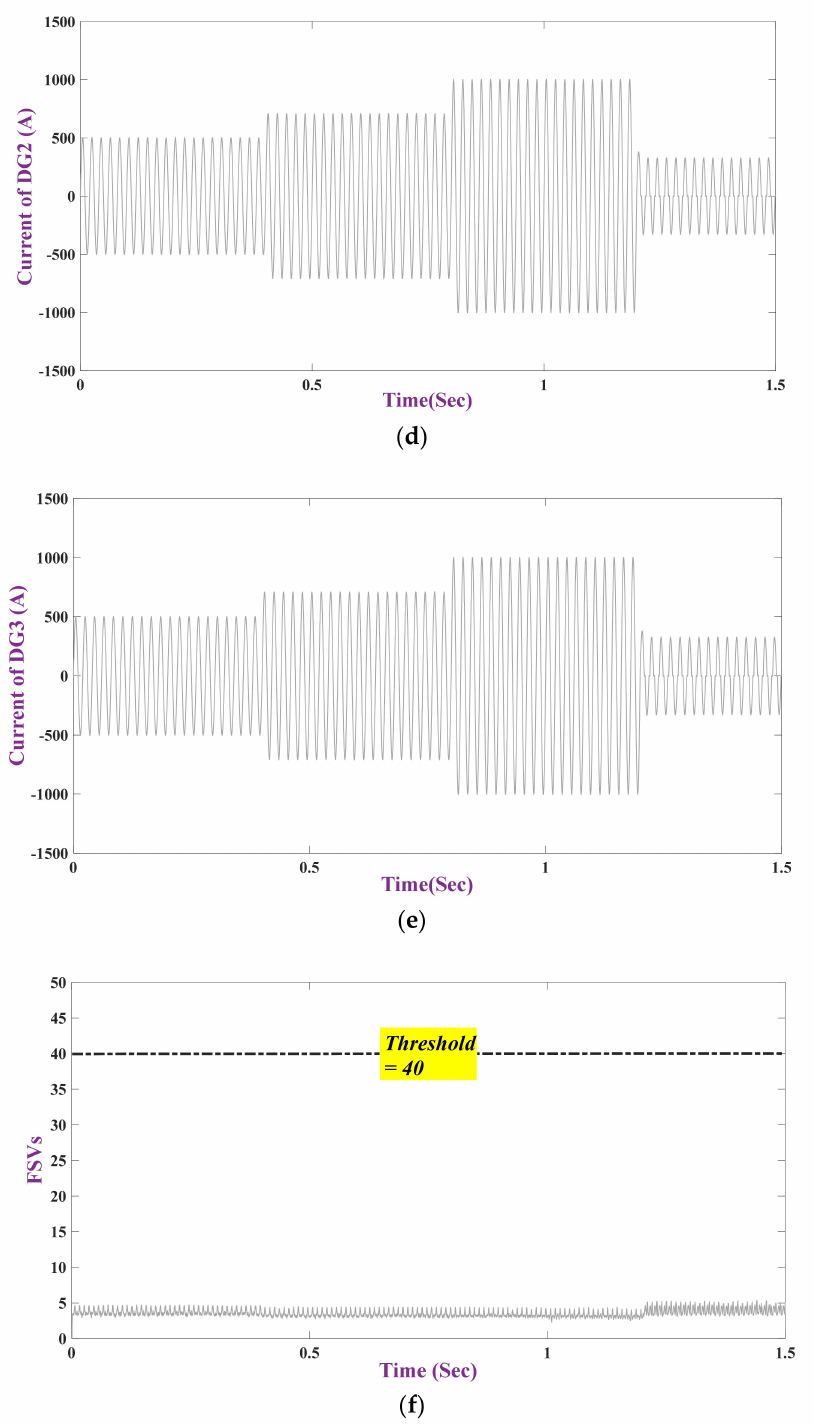
Figure 12. Load changing: ( a ) ISMG’s voltage; ( b ) Load’s waveform current; ( c ) Current waveform of DG 1 ; ( d ) Current waveform of DG 2 ; ( e ) Current waveform of DG 3 ; ( f ) FSVs of